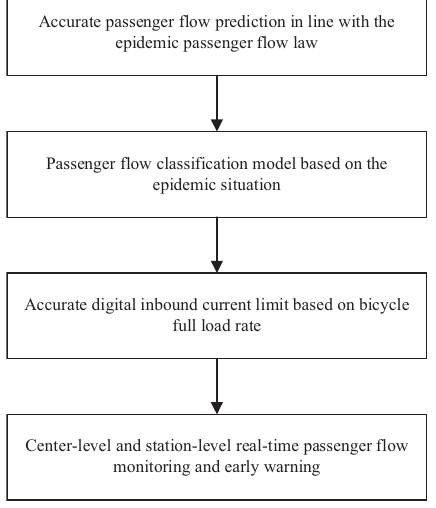
Accurate passenger flow prediction in line with the epidemic passenger flow